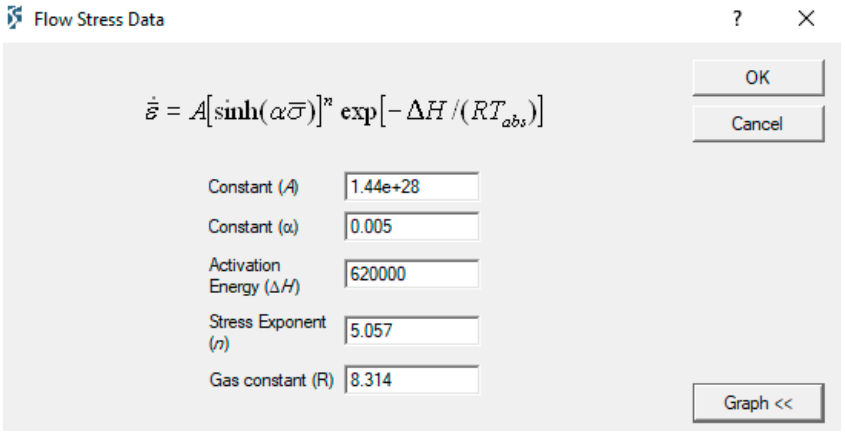
Figure 1. Deform-3D interface for computing constitutive constants. Table 2. Forging simulation parameters using DEFORM-3D.